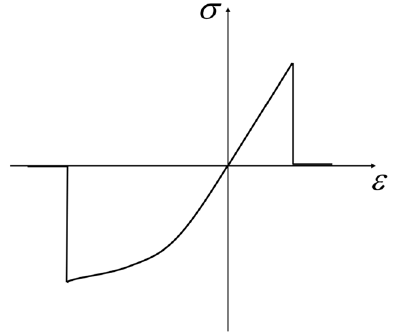
Figure 5. ε - σ relation of the resin matrix. Figure 5. ε − σ relation of the resin matrix.